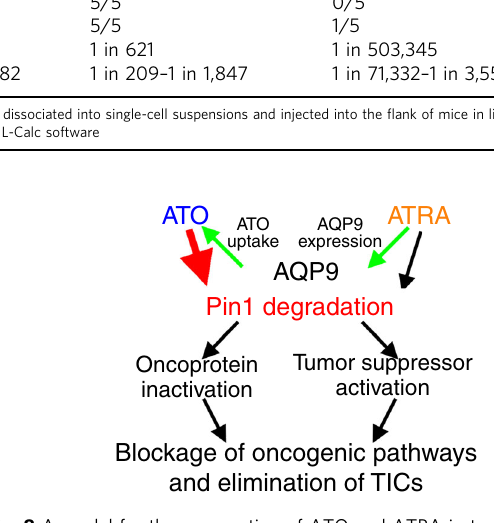
Fig. 8 A model for the cooperation of ATO and ATRA in targeting Pin1 to block multiple oncogenic pathways and eliminate cancer stem cells,